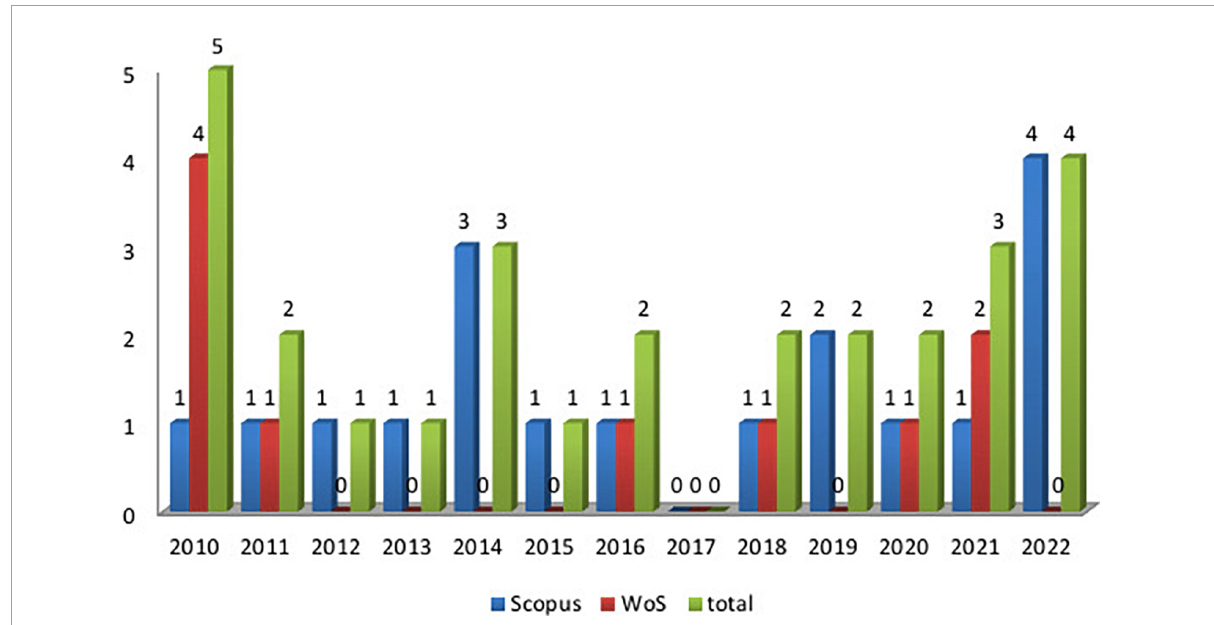
FIGURE3 Articles published in Scopus and WoS databases since 2010 on early school leavers in Spain.